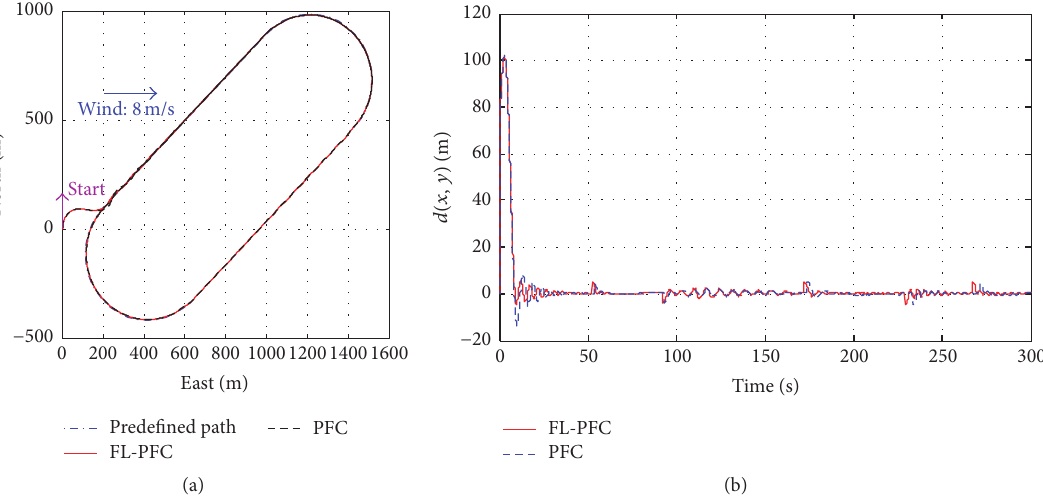
Figure 9: Comparison of the Athletics track-style path following with the methods FL_PFC and PFC. (a) The position compassion and (b) the distance 𝑑(𝑥,𝑦) compassion.